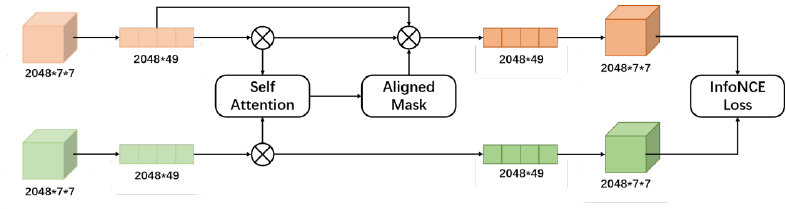
Figure 3. InfoNCE Loss with alignment module.